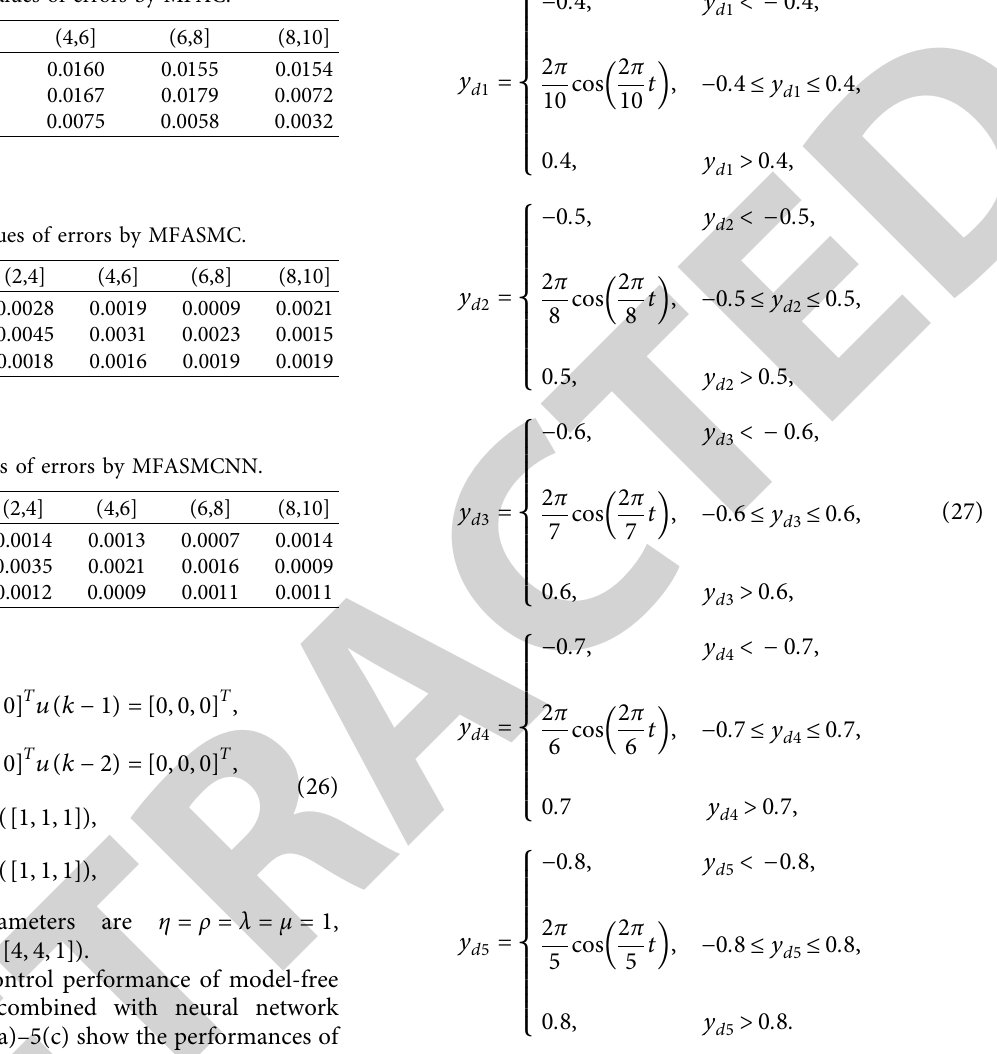
Table 1: RMS values of errors by MFAC.